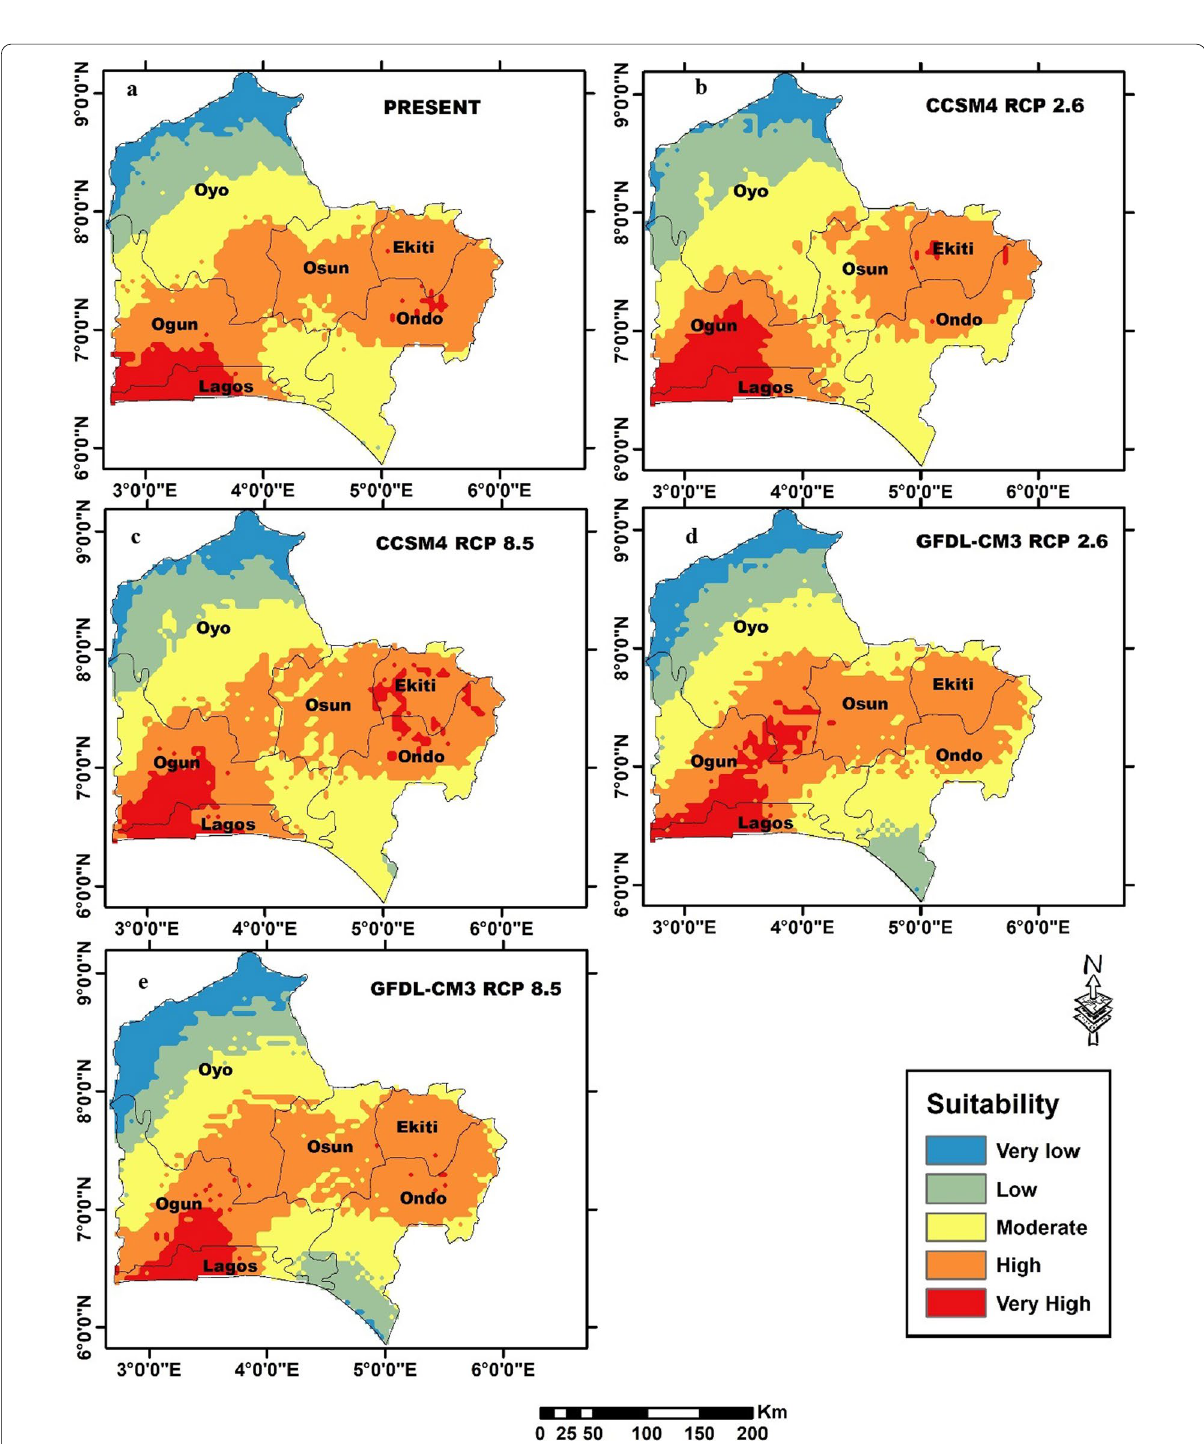
Fig. 3 Model picture of climatic suitability of present-day and future conditions for An.